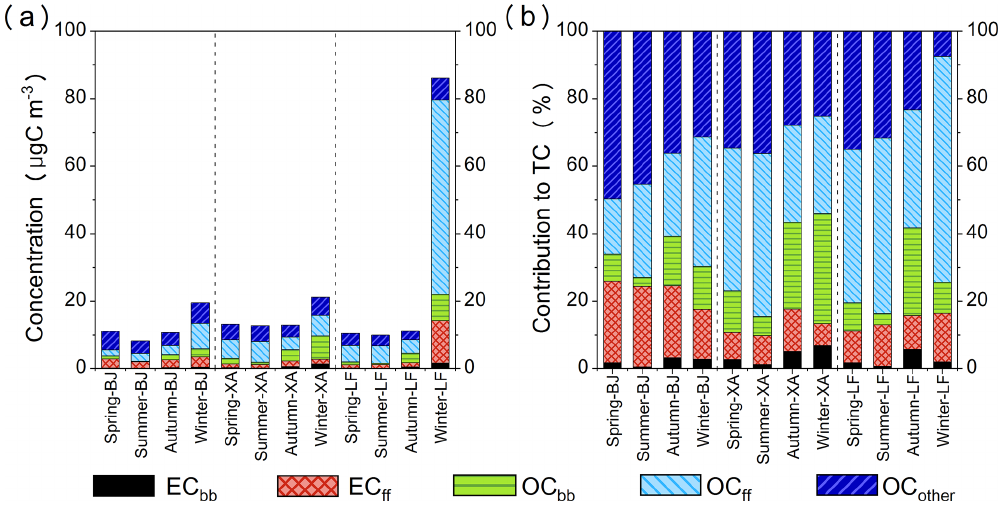
Figure 9. Mass concentrations (µgCm − 3 ) (a) and percentage (b) of elemental carbon from biomass burning (EC bb ) and fossil-fuel com- bustion (EC ff ), organic carbon from biomass burning (OC bb ), fossil-fuel combustion (OC ff ), and other sources (OC other ) for carbonaceous aerosol samples in BJ, XA, and LF during different